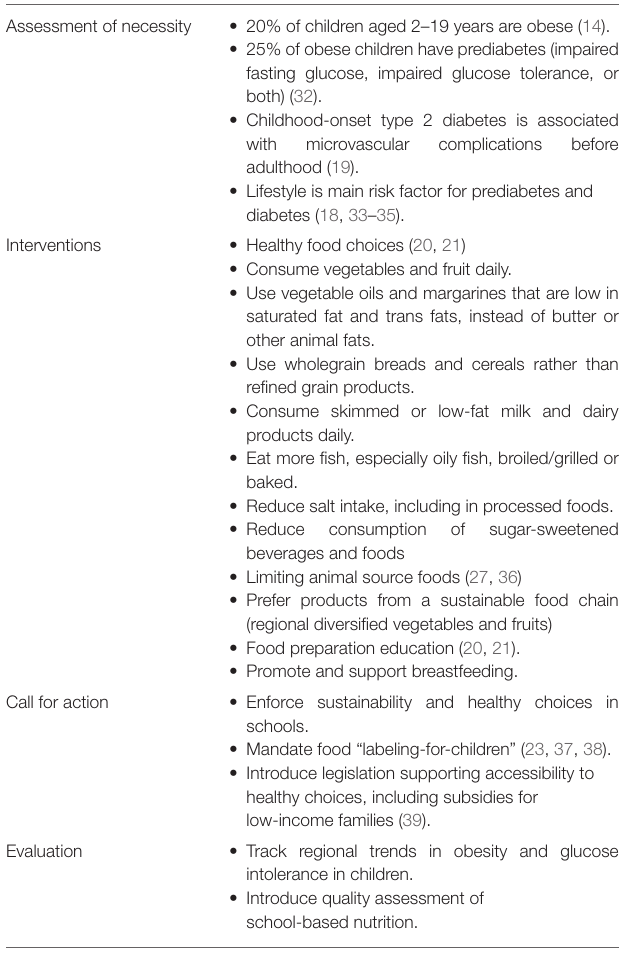
TABLE 1 | Nutrition. Assessment of